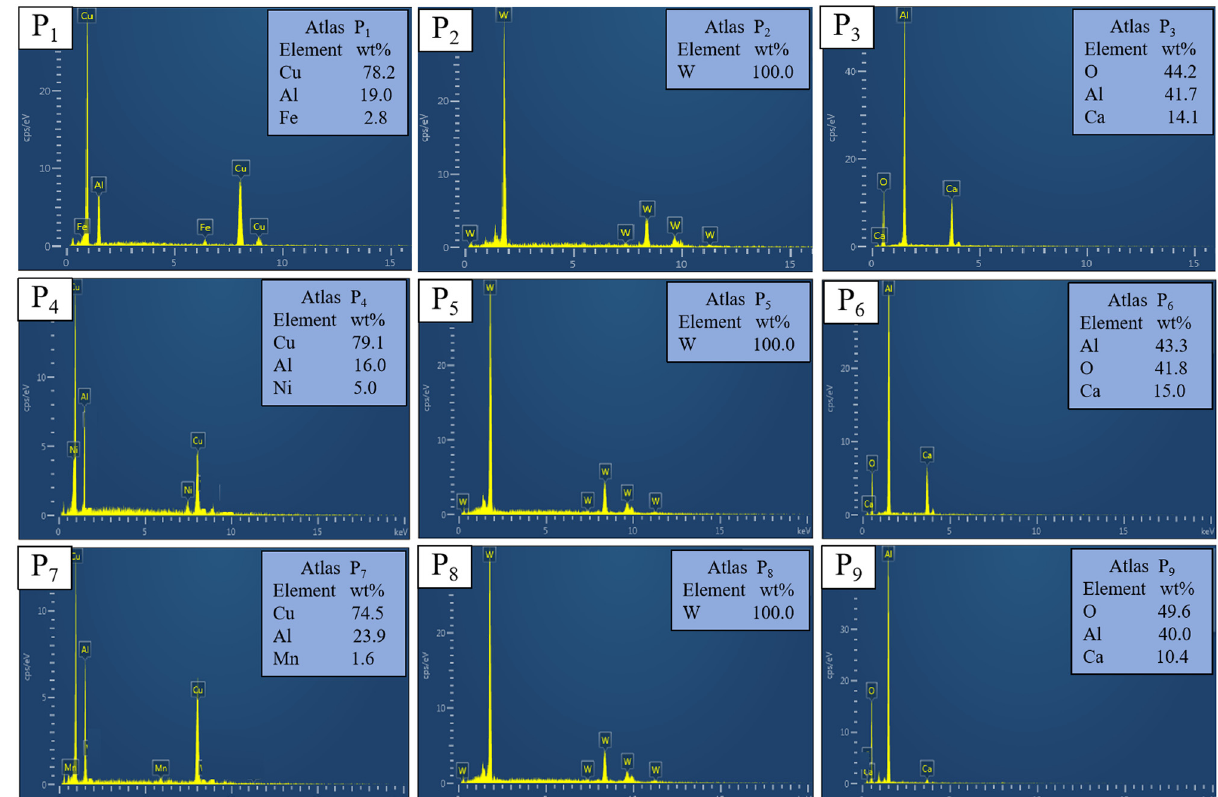
Figure 3: EDS analysis of Point ( P 1 – P 9 ) in Figure